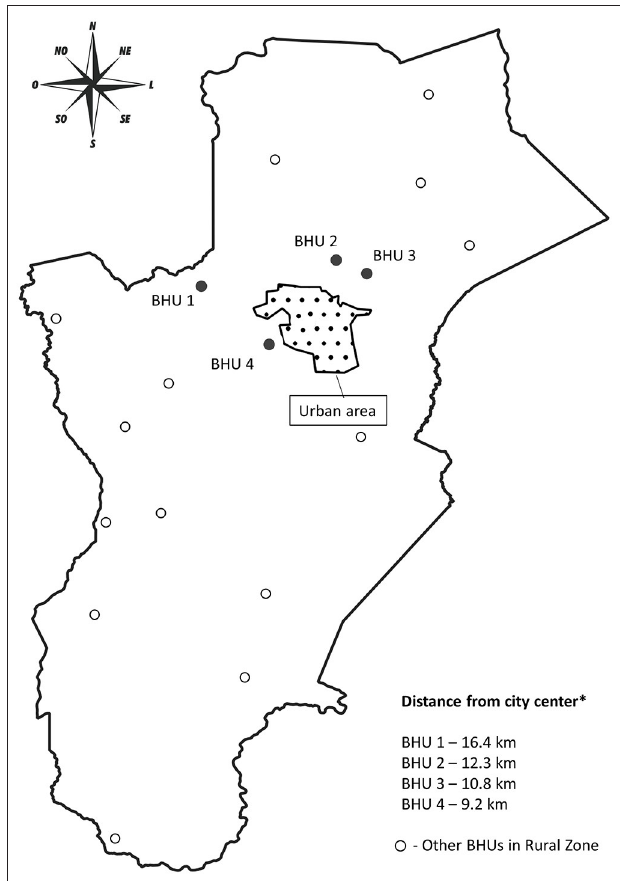
FIGURE 1 | Map of the municipality with the geospatial distribution of the basic health units in the rural area of study.